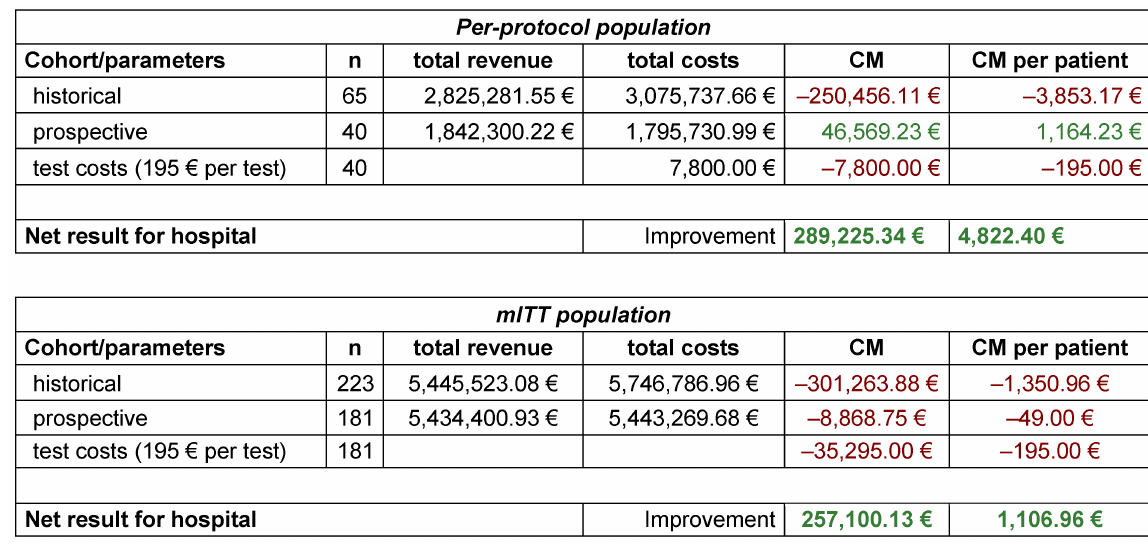
Table 6: Total economical